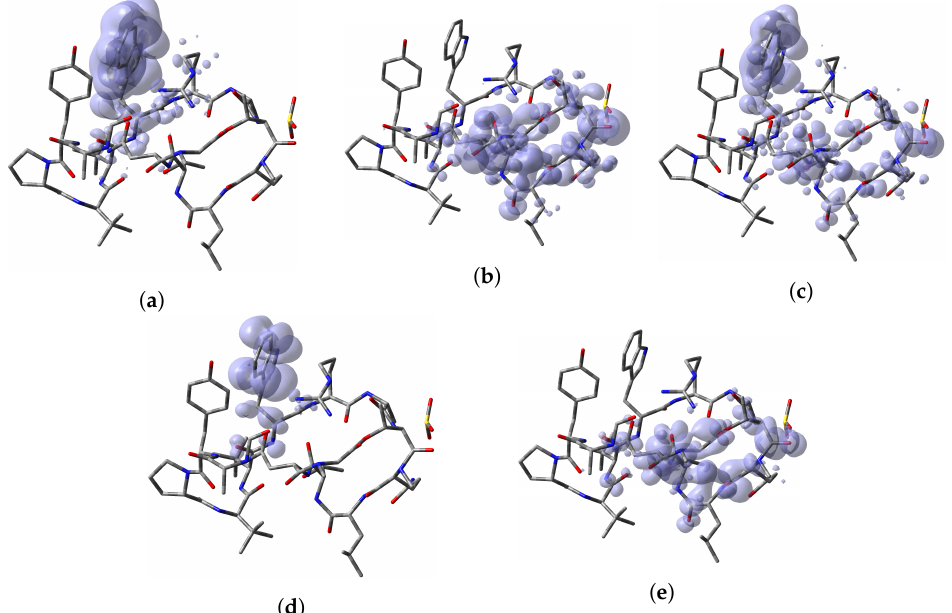
Figure A8. Graphical sketches of the local reactivity descriptors for Discodermin H showing the reactivity regions: ( a ) Electrophilic Fukui Function f − , ( b ) Nucleophilic Fukui Function f + , ( c ) Radical Fukui Function f 0 , ( d ) Electrophilic Parr Function P − and ( e ) Nucleophilic Parr Function P +